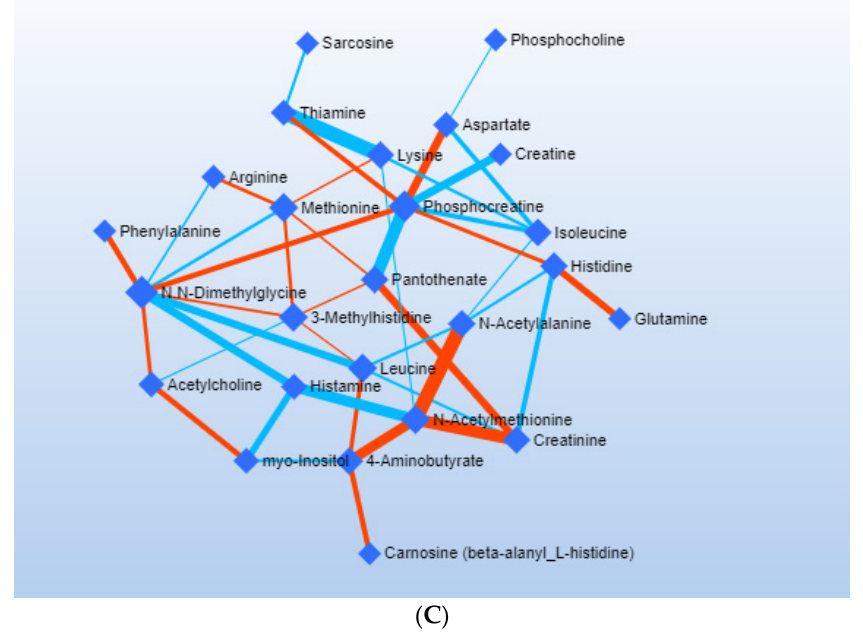
Figure 7. ( A ) The timeline according to the analysis results of different time points. ( B ) Heatmap of the selected metabolite from BML related to muscle loss. ( C ) Network of the selected metabolite (blue diamonds) with intensity of connections (red: higher intensity; blue: lower intensity) from BML. Pathway analysis.